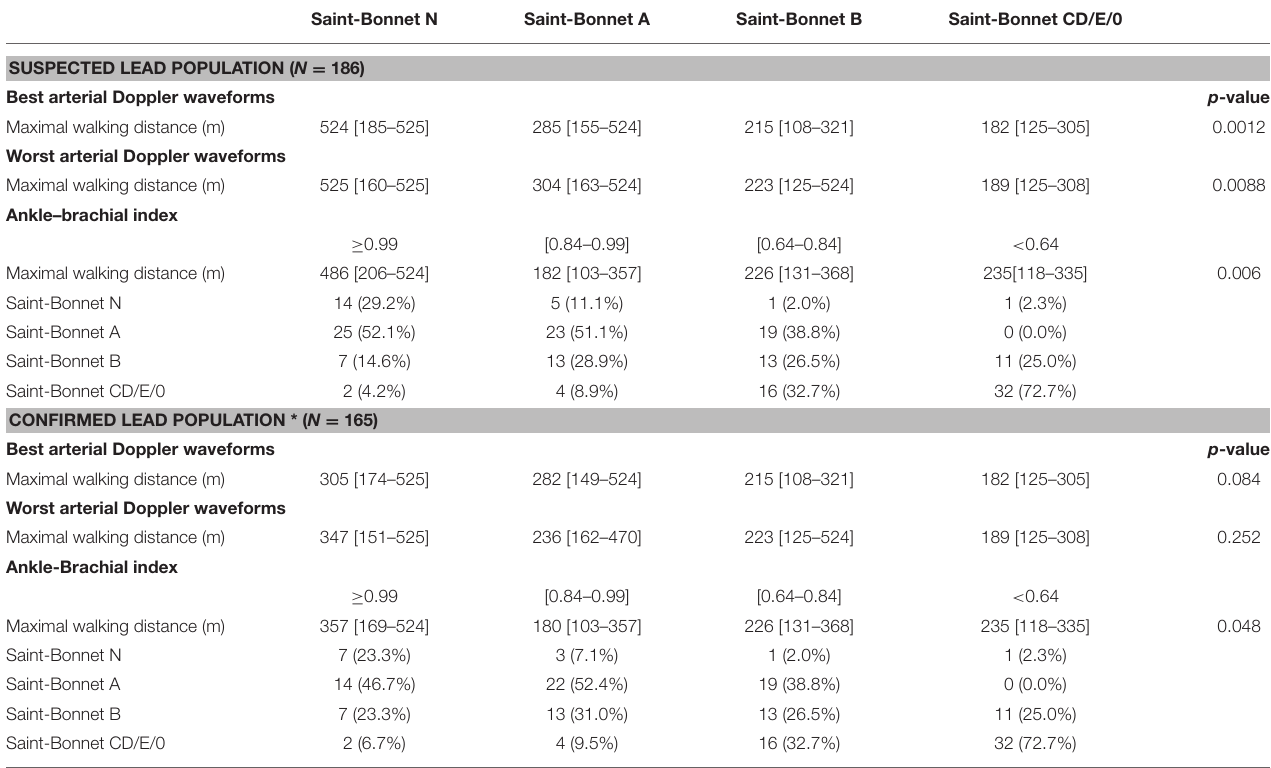
TABLE 2 | Maximal walking distance according to Saint-Bonnet Classification and